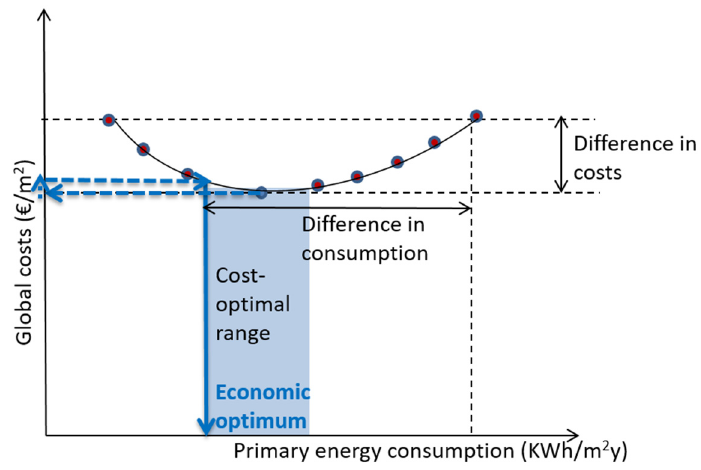
Figure 1. Different variants within the graph and position of the cost-optimal range.